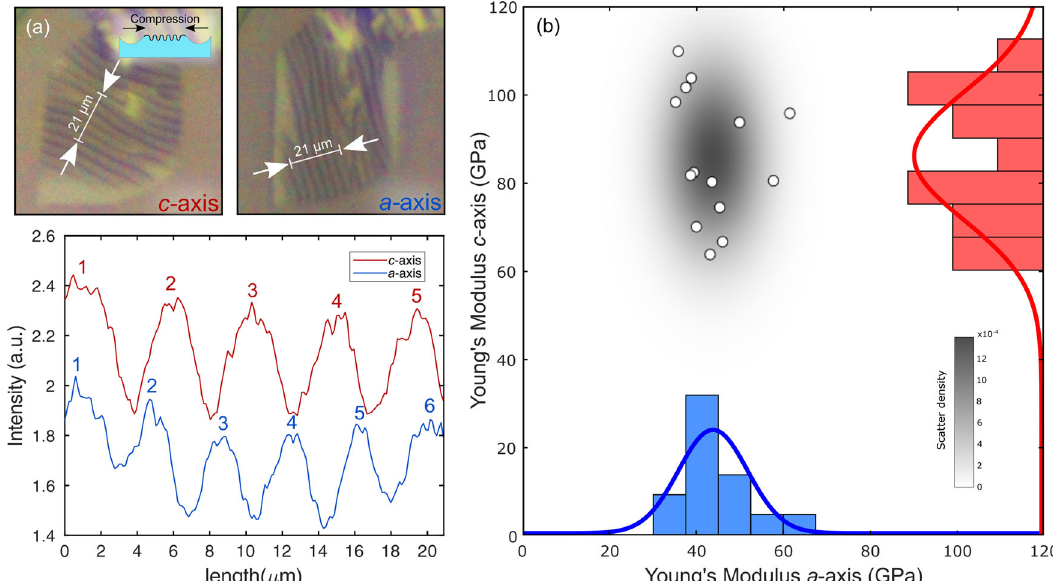
Fig. 4 Anisotropic mechanical properties of MoO 3 fl akes. a Optical images of a MoO 3 fl ake on Gel-Film substrate applying compression along a and c axes (top images), inset: process of ripples formation; determination of the wavelength of periodic ripples (bottom fi gure). b Scatter density plot of Young ’ s modulus values along the two directions obtained from 14 different samples, white circles with black edges, and fi tted with a multivariate Gaussian normal distribution function, in gray. Inset: Histogram plots of Young ’ s modulus along the a-axis (blue) and the c-axis (red), fi tted with a Gaussian